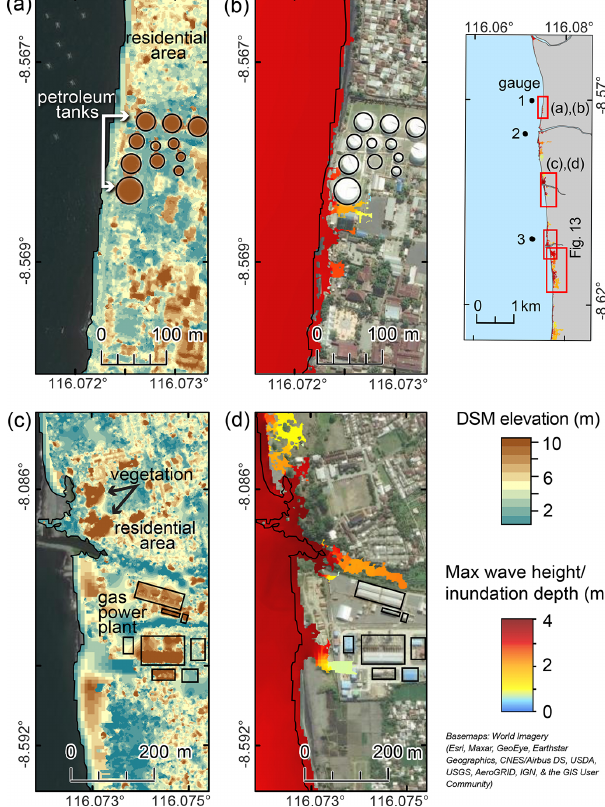
Figure 12. The DSM elevation and inundation on the northern coast of Mataram associated with 5m of coseismic slip on the Flores Thrust ramp (model A-5) overlain on World Imagery. Flow depth is generally ≤ 1 . 5m. (a, b) The inundation extent is limited by the high density of structures in residential areas. The inundation reaches ∼ 95m at the industrial site (circular features are petroleum tanks), where there are more open spaces. (c, d) Inundation may be underestimated in regions where vegetation clusters act in the model as wide barriers to flow but may be more porous, as shown on the upper half of the map. In the area of the gas power plant, where there is less vegetation and the structures are more widely spaced, the inundation extent is ∼ 140m. Right image – location map of panels (a–d)